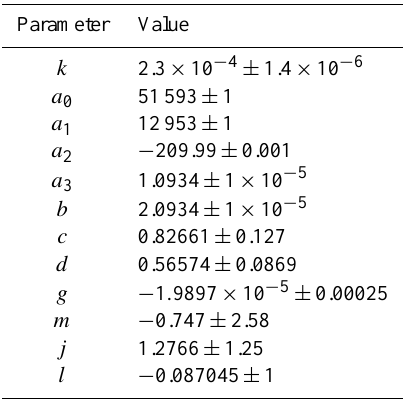
Figure 7. Calculated [H 2 SO 4 ] vs. measured [H 2 SO 4 ] for binary and ternary organic nucleation runs. The presence of ions during the pinanediol runs leads to an excess of measured H 2 SO 4 . The de- viation between the parameterised and the measured concentrations for the charged runs indicates the magnitude of the ion effect on the CIMS measurement. Table 1. Coefficients ( ± SD) of parameters used in the H 2 SO 4 pa- rameterisation formula.